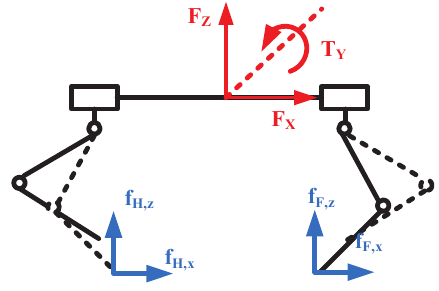
Figure 5. The static force diagram of the SCalf